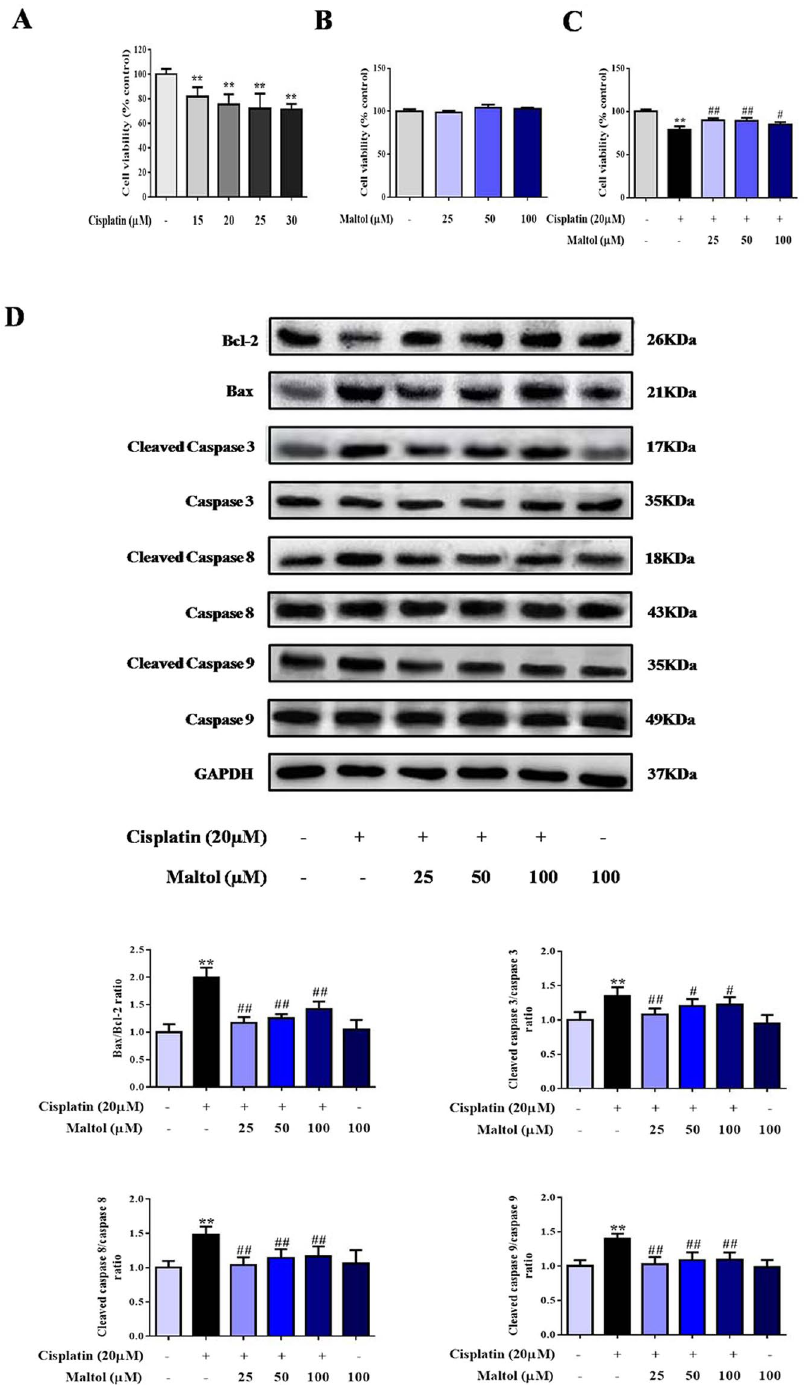
Figure 5. Protective effects of maltol on cisplatin-induced injury in HEK293 cells. ( A ) The cytotoxic effects of cisplatin on HEK293 cells. ( B ) Effect of maltol on the activity of normal cells. ( C ) The viability of HEK293 cells incubated with maltol after cisplatin exposure. Effects of maltol on the protein expression levels of Bcl-2, Bax and caspase 3, 8, 9 as well as GAPDH protein was used as a loading control. ( D ) Cells were used for western blot analysis of indicated proteins (upper panel). Column chart represents relative protein levels compared with the control group after normalization to GAPDH levels (lower panel) Values are expressed as mean ± S.D. n = 8. ** p < 0.01 vs . normal group; # p < 0.05, ## p < 0.01 vs . cisplatin